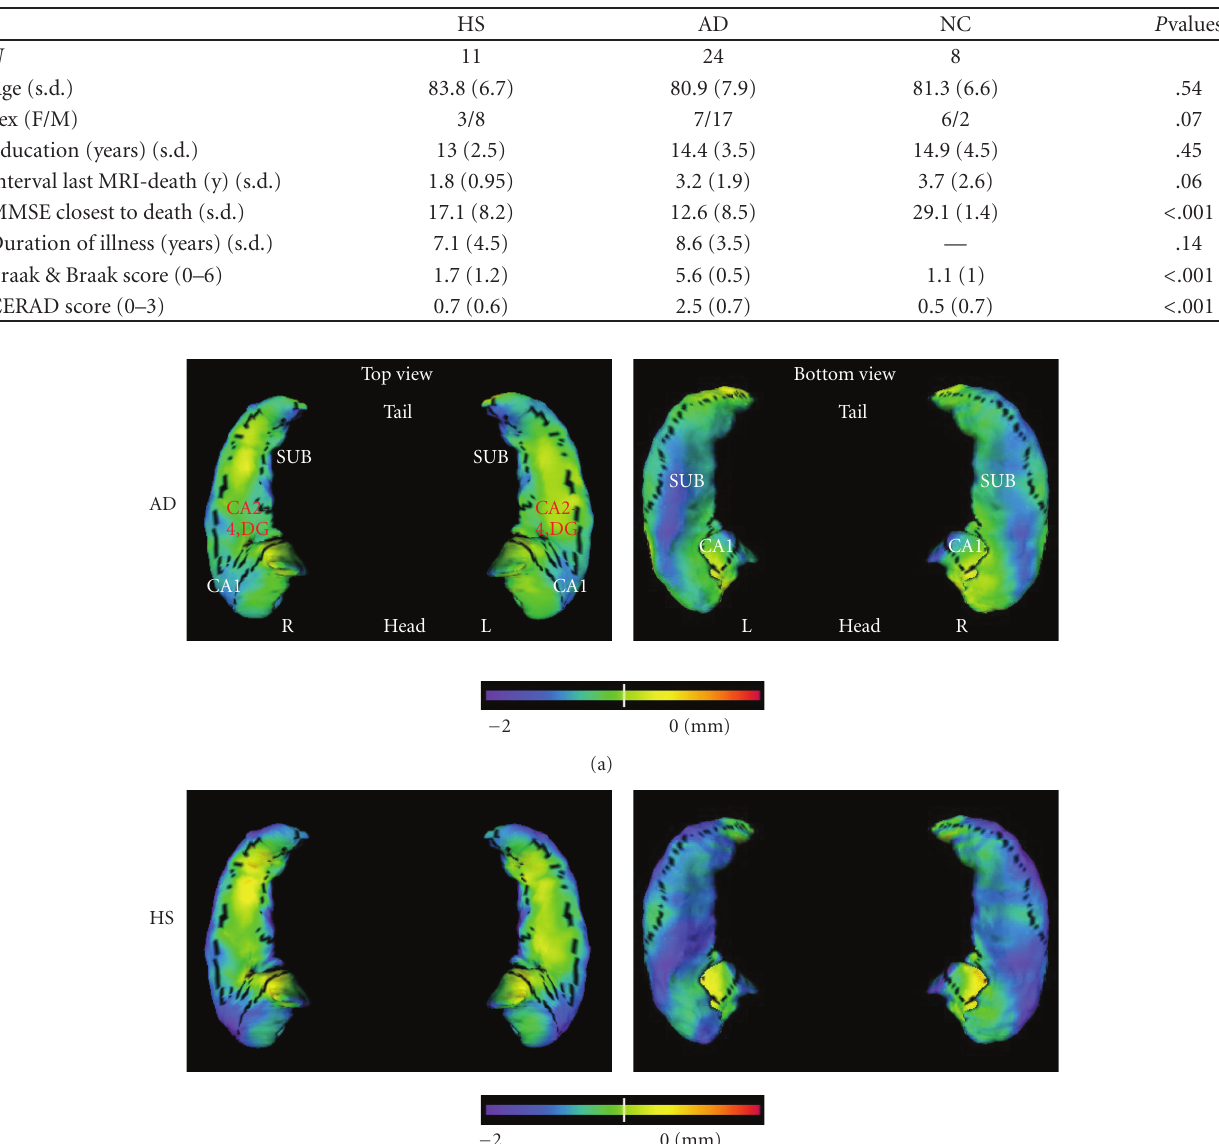
Table 1: Characteristics of the three groups.